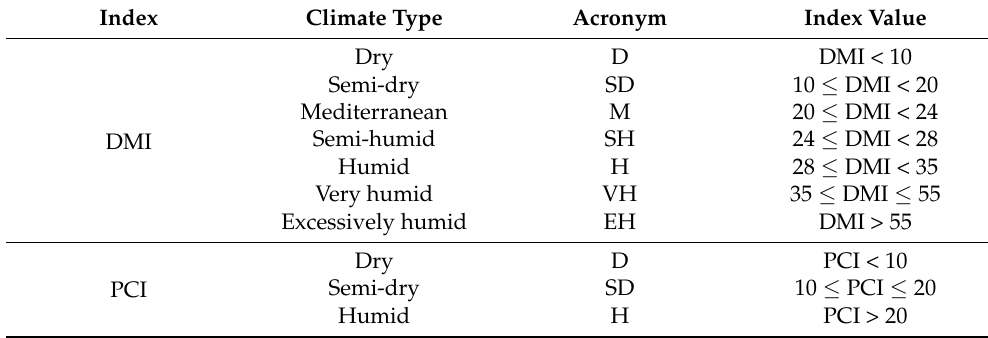
Table 1. Climatic classification for the De Martonne (DMI) and Pinna combinative index (PCI).